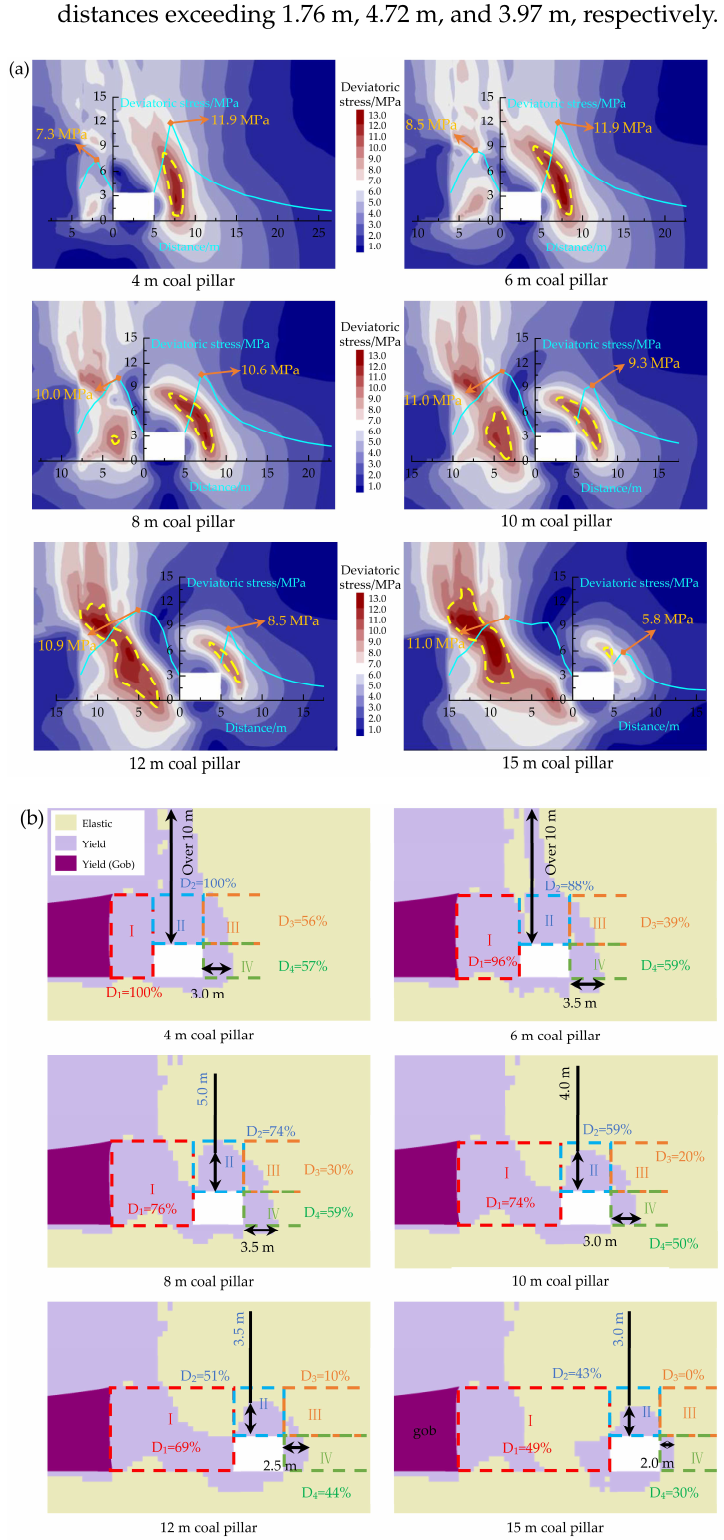
Figure 8. Characteristics of the surrounding rock with various coal pillar widths. ( a ) Deviatoric stress. ( b ) The plastic